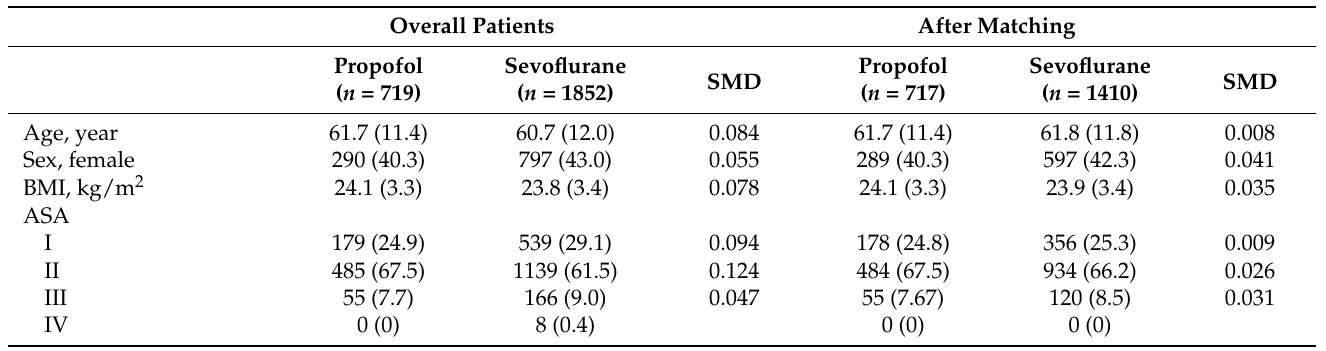
Table 1. Baseline characteristics of study population before and after propensity score